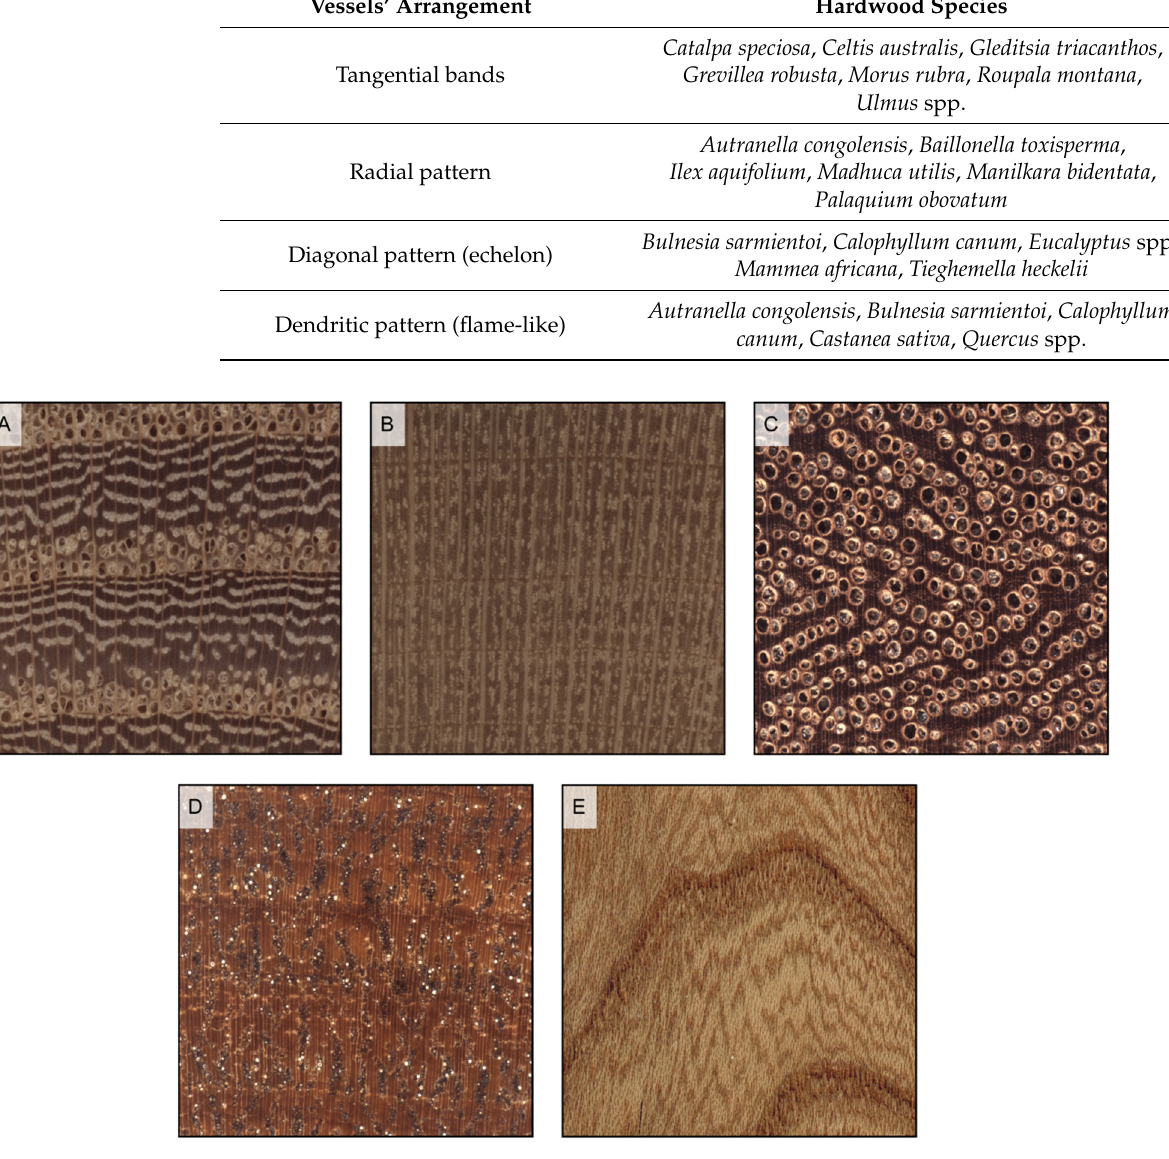
Table 13. Examples of species for different types of vessels’ groupings.